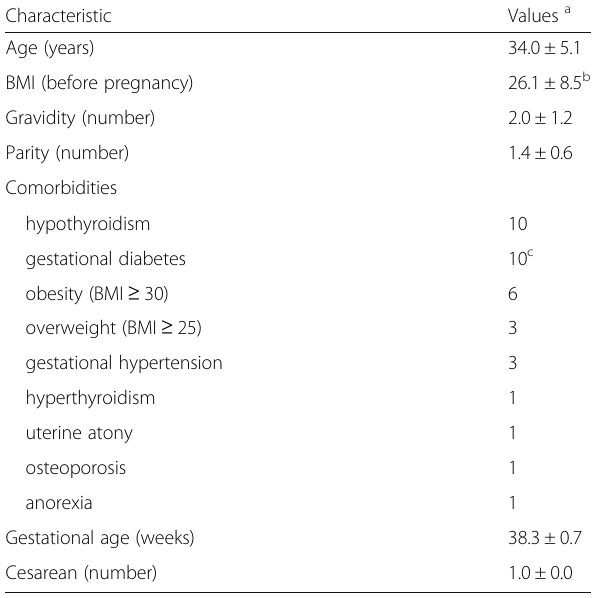
Table 1 Characteristics of the patients who donated the myometrium biopsies analyzed in the present work ( n = 60) Characteristic Values a Age (years)